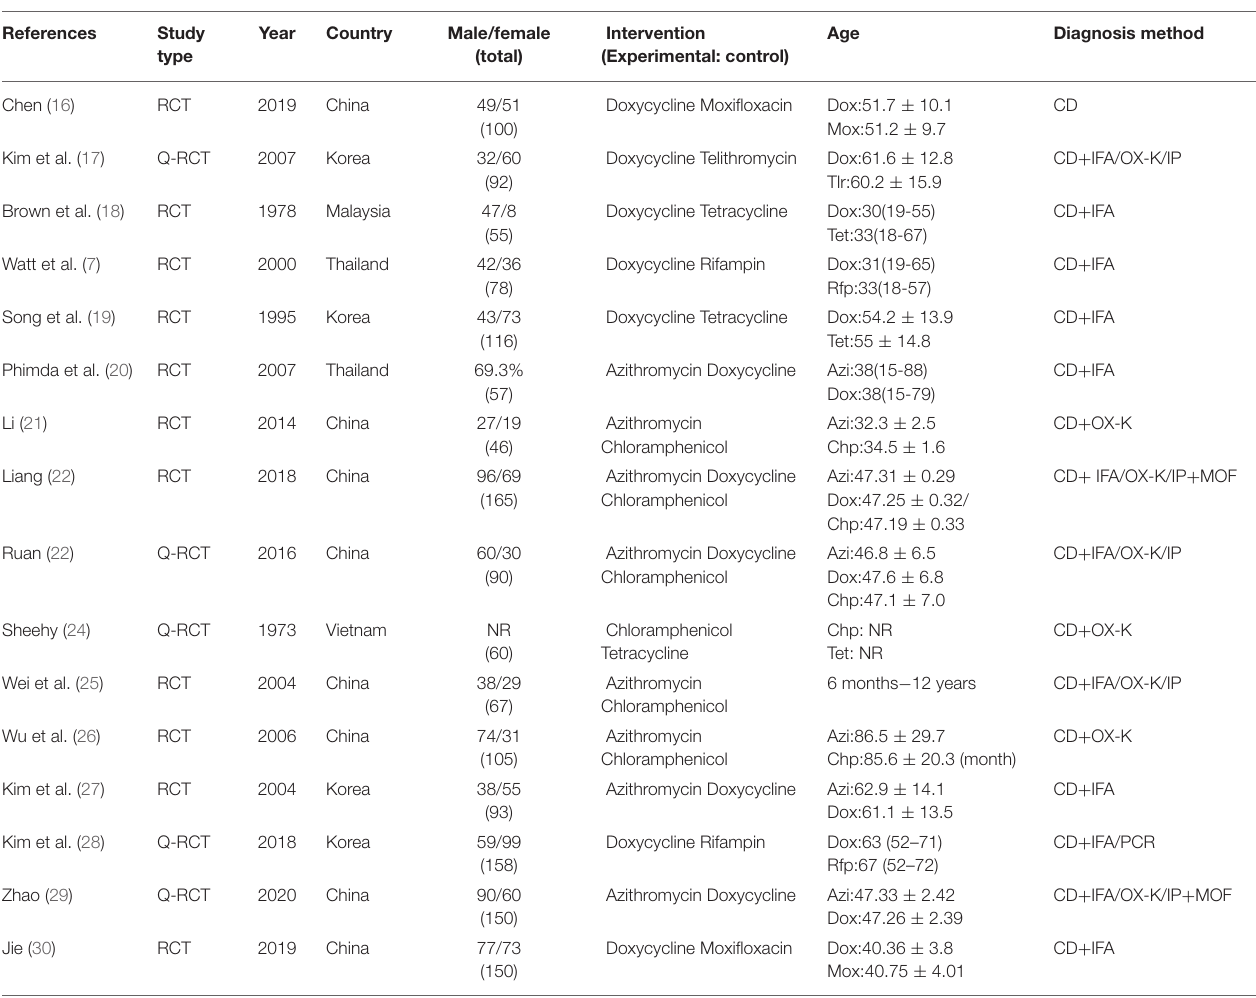
TABLE 1 | Baseline characteristics of studies included in the network